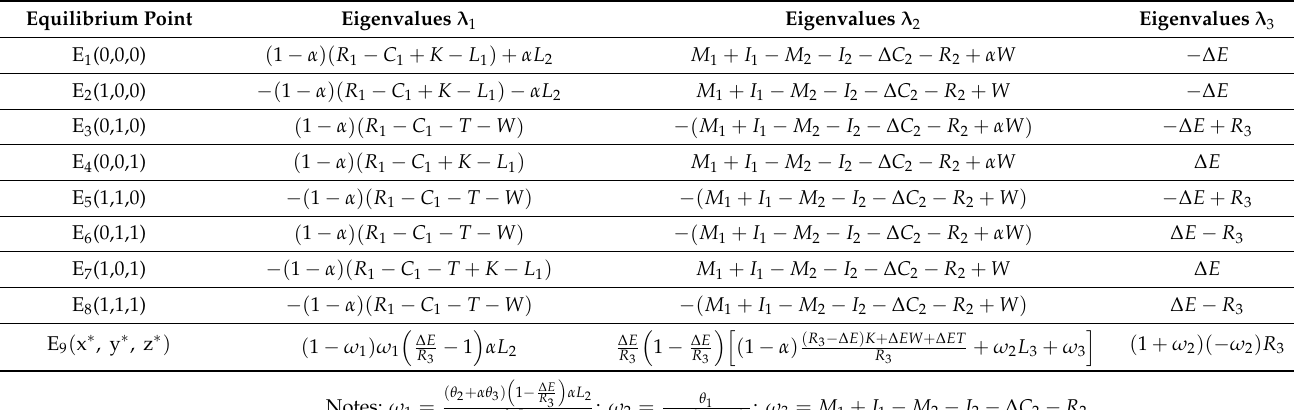
Table 5. Eigenvalues of the Jacobian